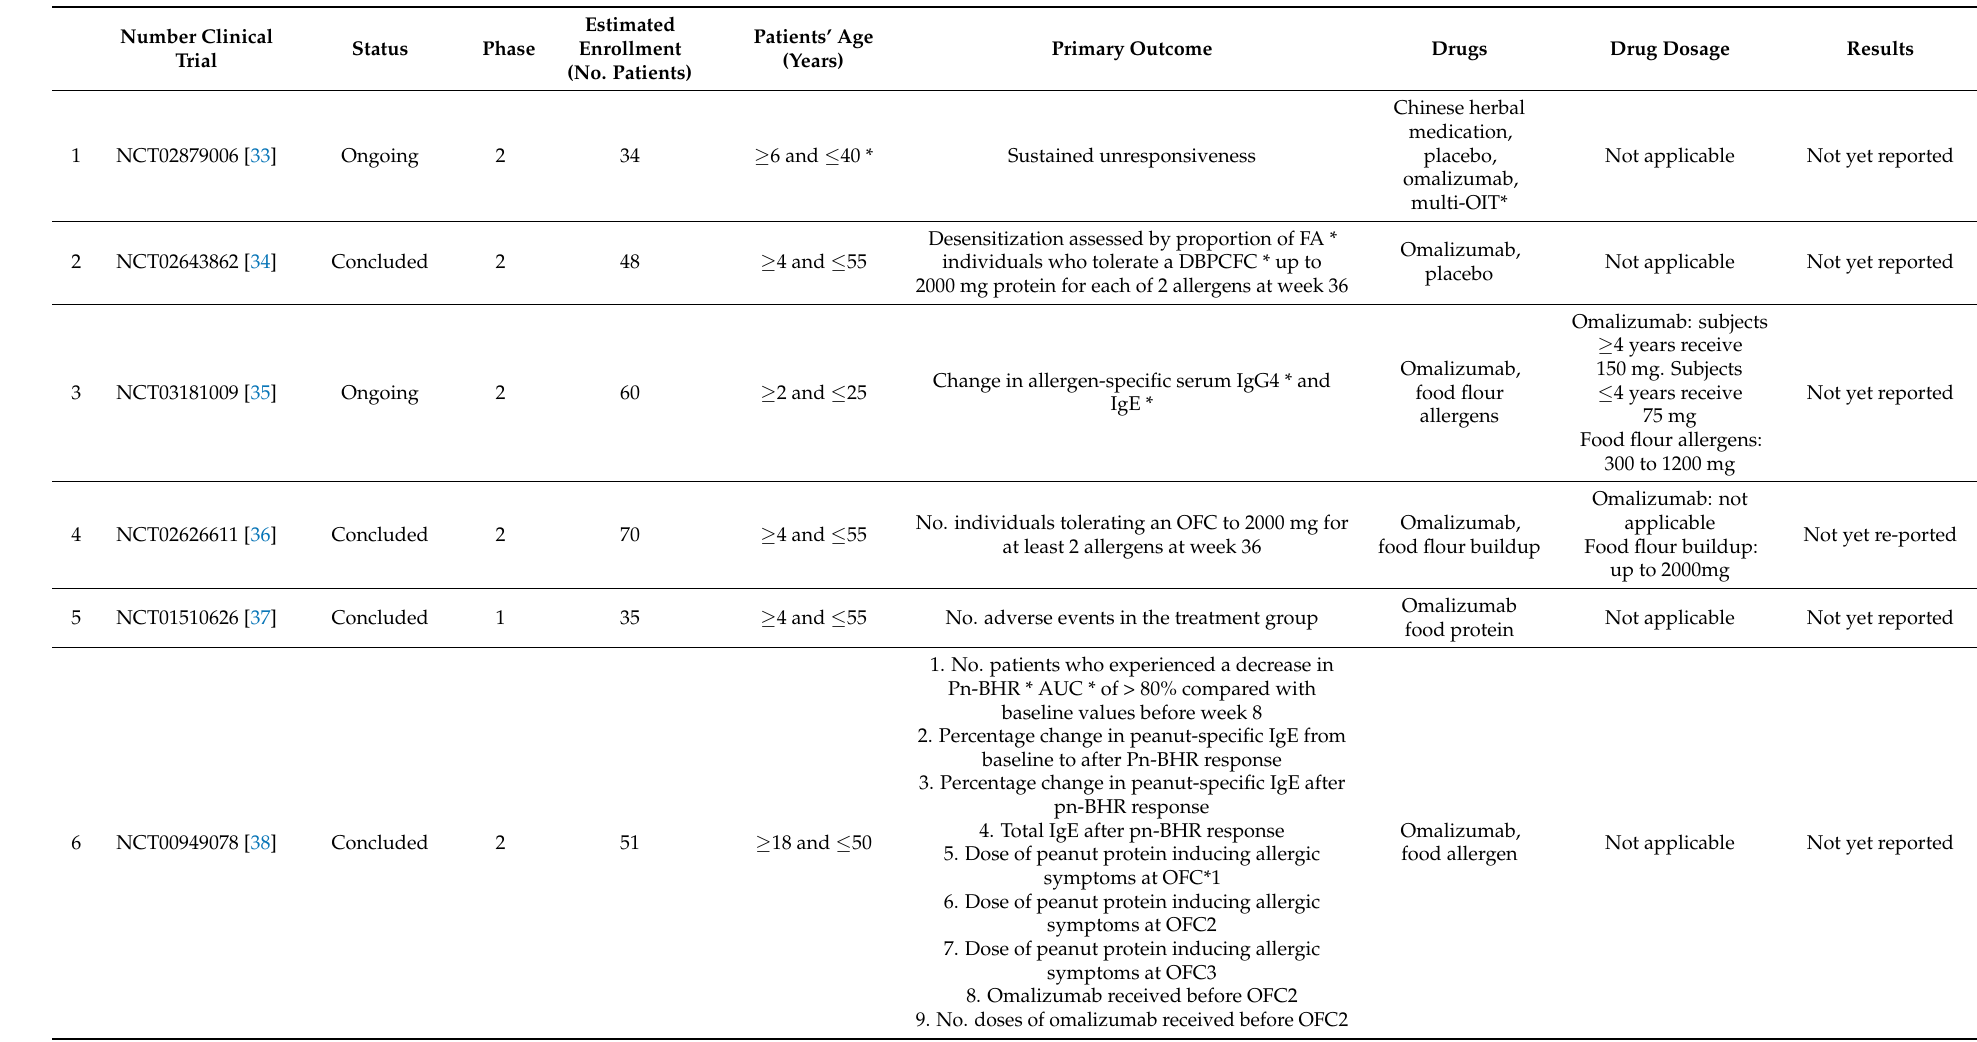
Table 2. Randomized Clinical Trials for omalizumab as monotherapy or as adjunctive treatment in food